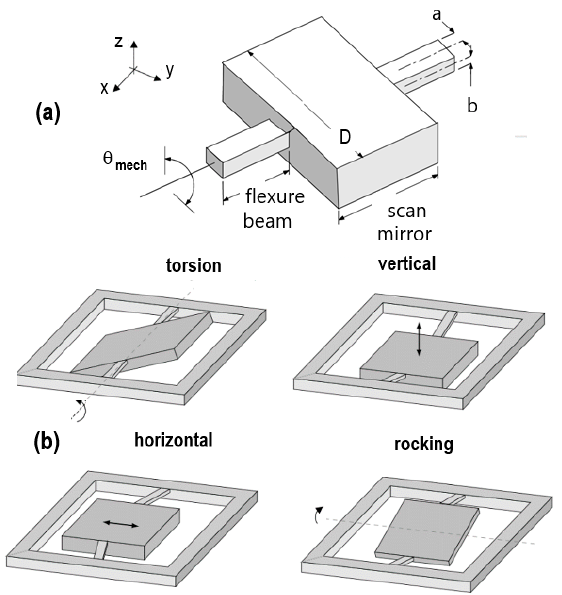
Figure 5. Torsional resonant scan mirror in ( a ) with its four fundamental vibration modes in ( b ).